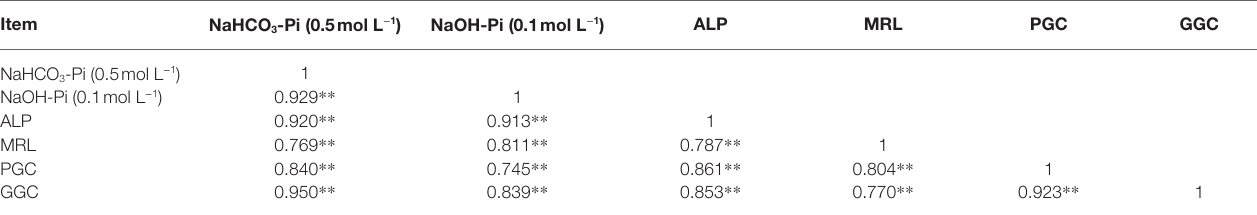
TABLE 3 | Correlation coefficients among fractions of soil P, phoD , and gcd gene abundance, alkaline phosphomonoesterase activity, and mineralization rate of lecithin in an age sequence of soil crusts under plantations ( n =